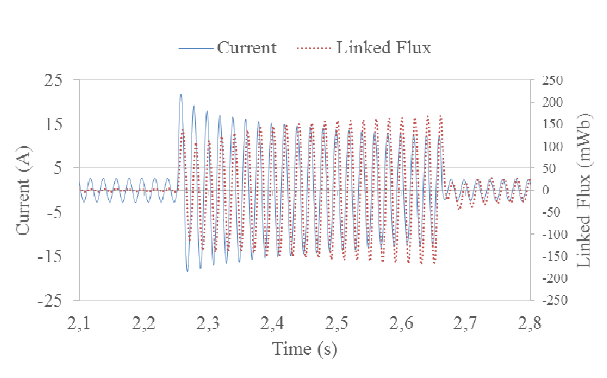
Fig. 8. Fault current limitation performance for prospective currents of 80 A regarding configuration A.